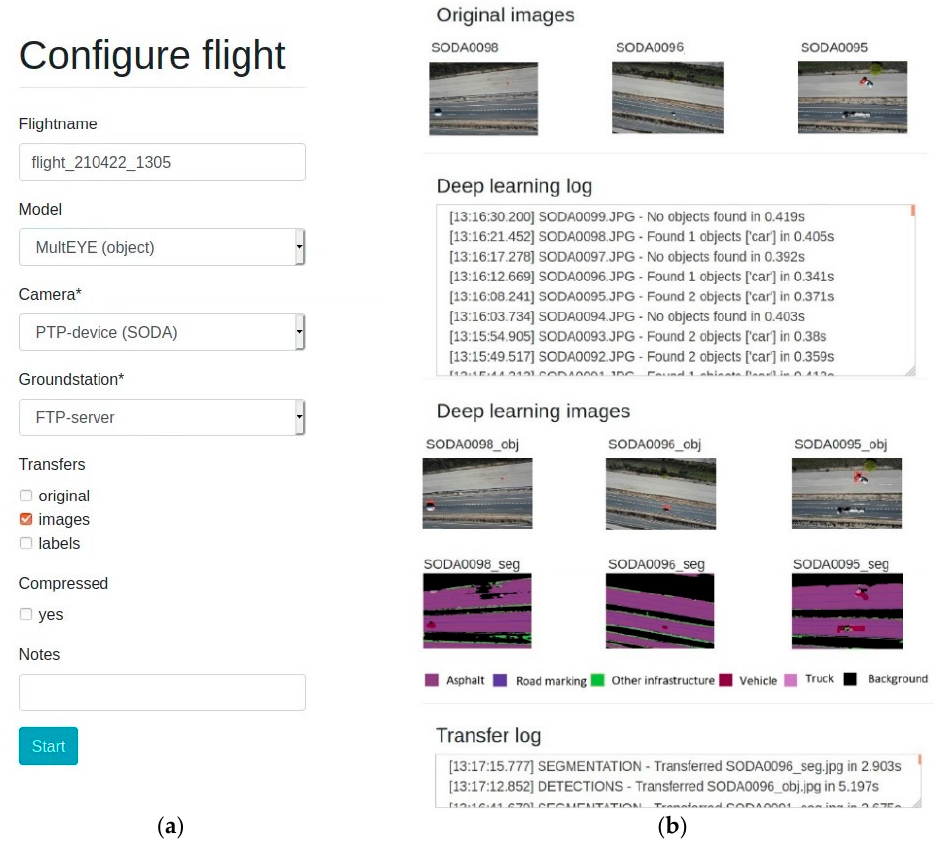
Figure 4. Web application front-end. ( a ) The landing page where users configure the UAV mission. ( b ) The monitoring dashboard showing mid-flight transfer logs, information variables produced by the deep learning suite, and image thumbnails for visualization purposes.